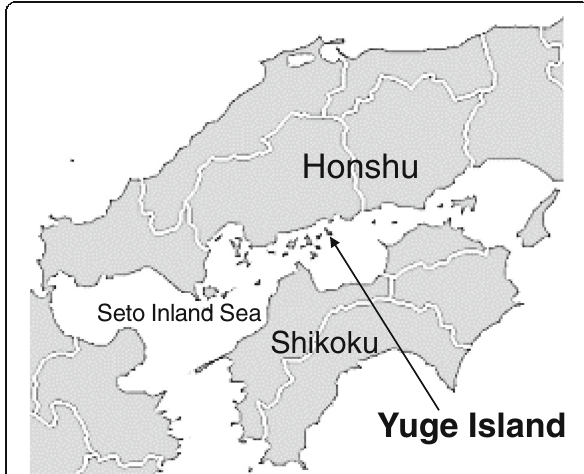
Fig. 1 Location of Yuge Island in the Seto Inland Sea of